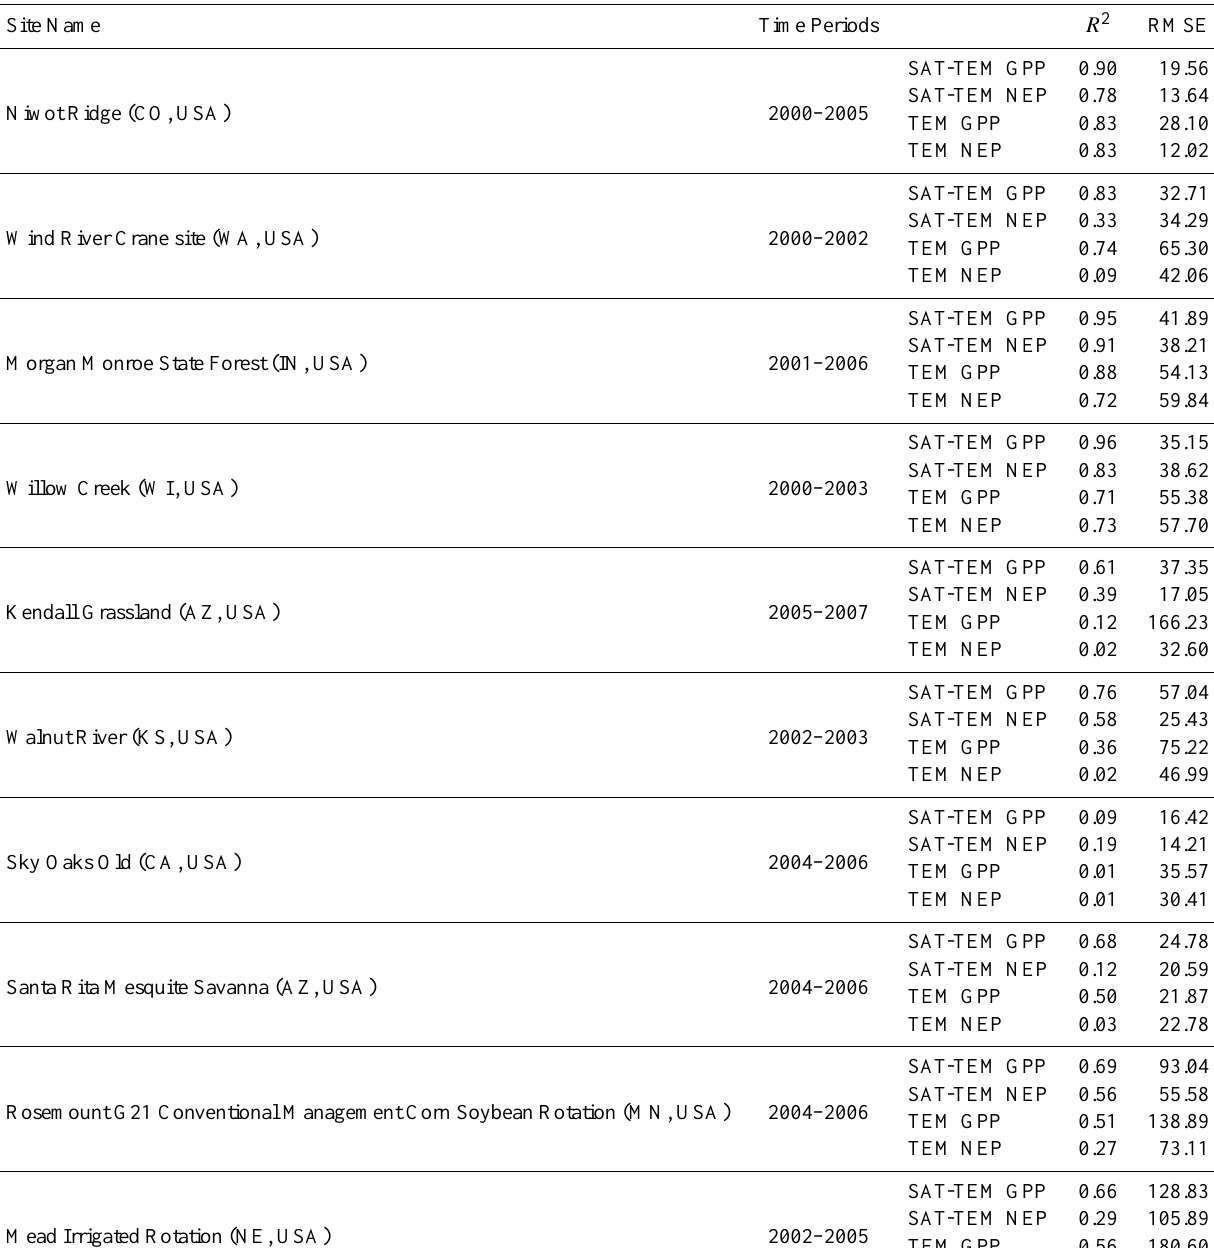
Table 5. Statistics for the observed and SAT-TEM and TEM predicted monthly GPP and NEP at each AmeriFlux site for parameterization. The units of RMSE are gCm − 2 month − 1